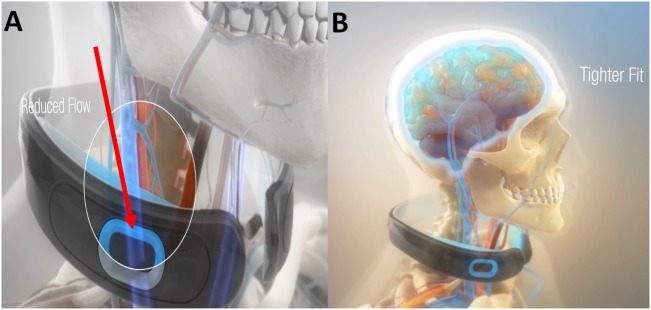
The Q-Collar designed to facilitate the actions of the compressive effect of the omohyoids to reduce blood outflow of the brain (A) and produce a tighter fit of the brain within the cranium (B).